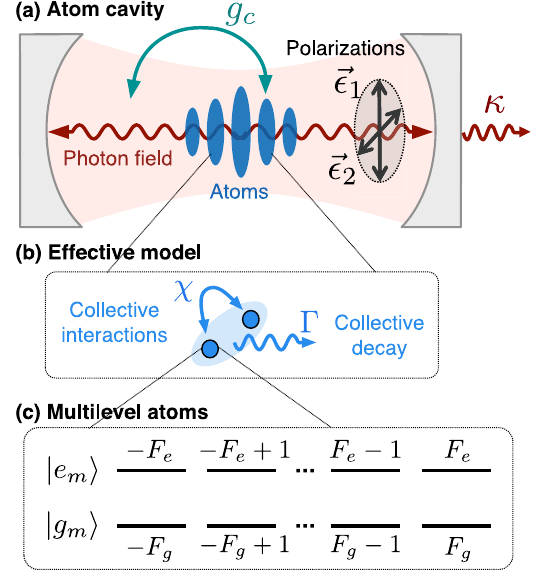
FIG. 1. Multilevel atoms in a two-mode cavity. (a) Sketch of the atom-cavity system. The atoms are assumed to be pinned by an external potential (e.g., an optical lattice) and couple to the photon field with strength g . The photon has two allowed polarizations ⃗ ϵ 1 c and ⃗ ϵ 2 , which are orthogonal to each other and to the cavity axis. The photons escape the cavity at a rate κ . (b) After adiabatically eliminating the photons, we obtain an effective atom-only model with photon-mediated collective elastic ( χ ) and inelastic ( Γ ) interactions. The inelastic part leads to superradiant decay, which in a multilevel system can generate an entangled steady state. The elastic part is set to zero, χ ¼ 0 for most of the work, except in Secs. IV and XI C. (c) Multilevel internal level structure of the atoms, which is composed of a ground ( g ) and an excited ( e ) manifold of states with angular momenta F and F , g e